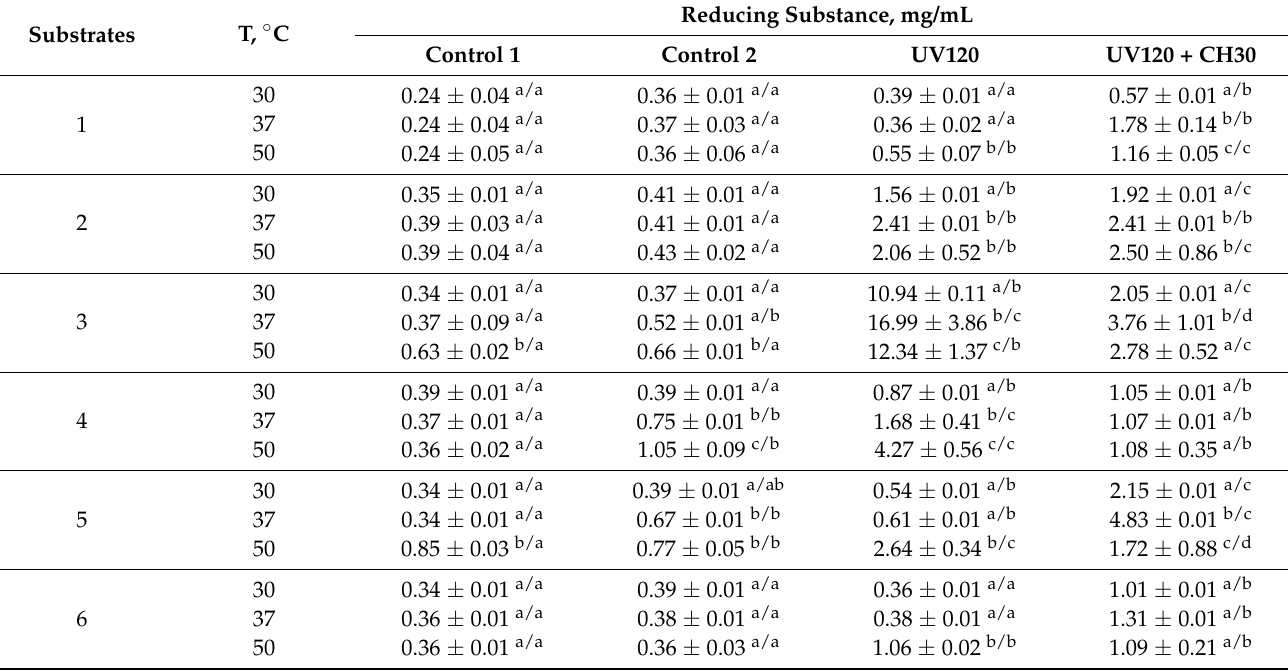
Table 5. Optimization of the temperature factor during enzymatic hydrolysis.